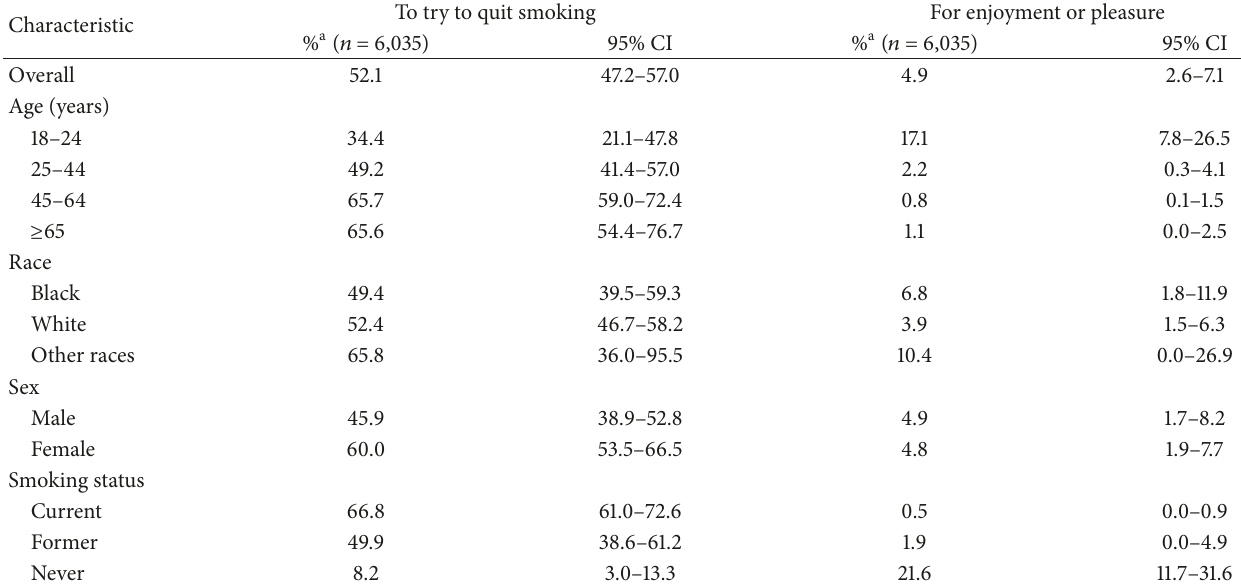
Table 4: Reasons for trying or using e-cigarettes among Mississippi adults who have ever tried e-cigarettes by select demographic characteristics, Behavioral Risk Factor Surveillance System, 2015.